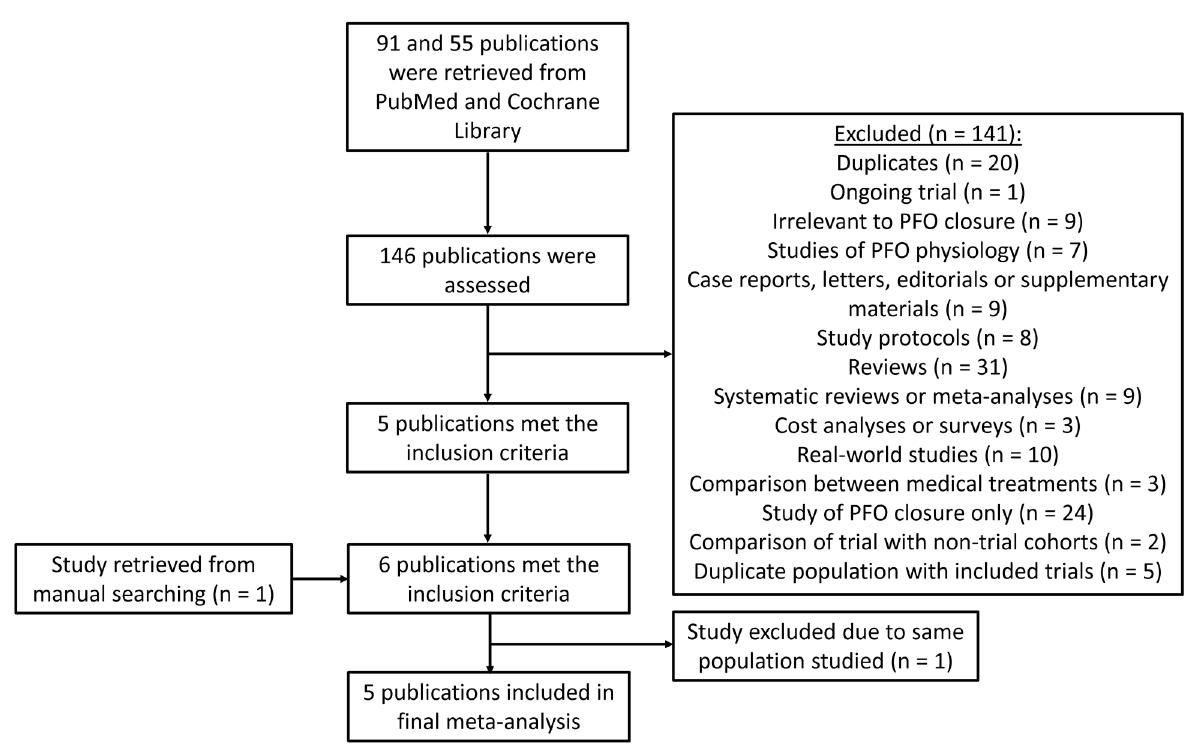
Figure 1. Flowchart of the database search and study selection process.